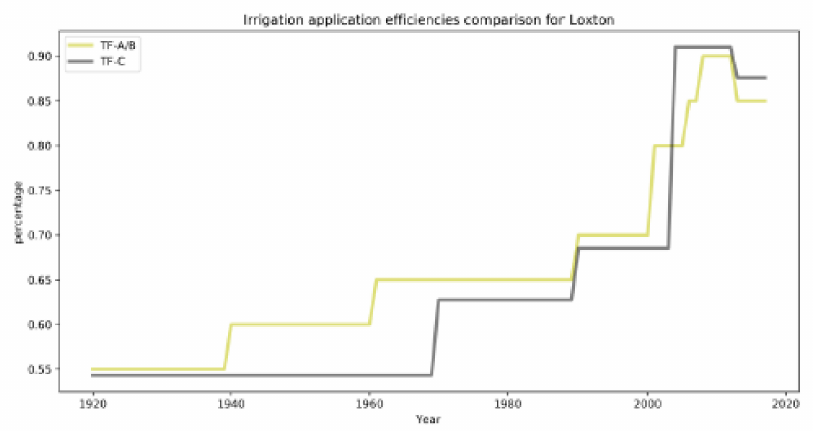
Figure 8. Irrigation e ffi ciency factor used in the TF-A / B and TF-C models.